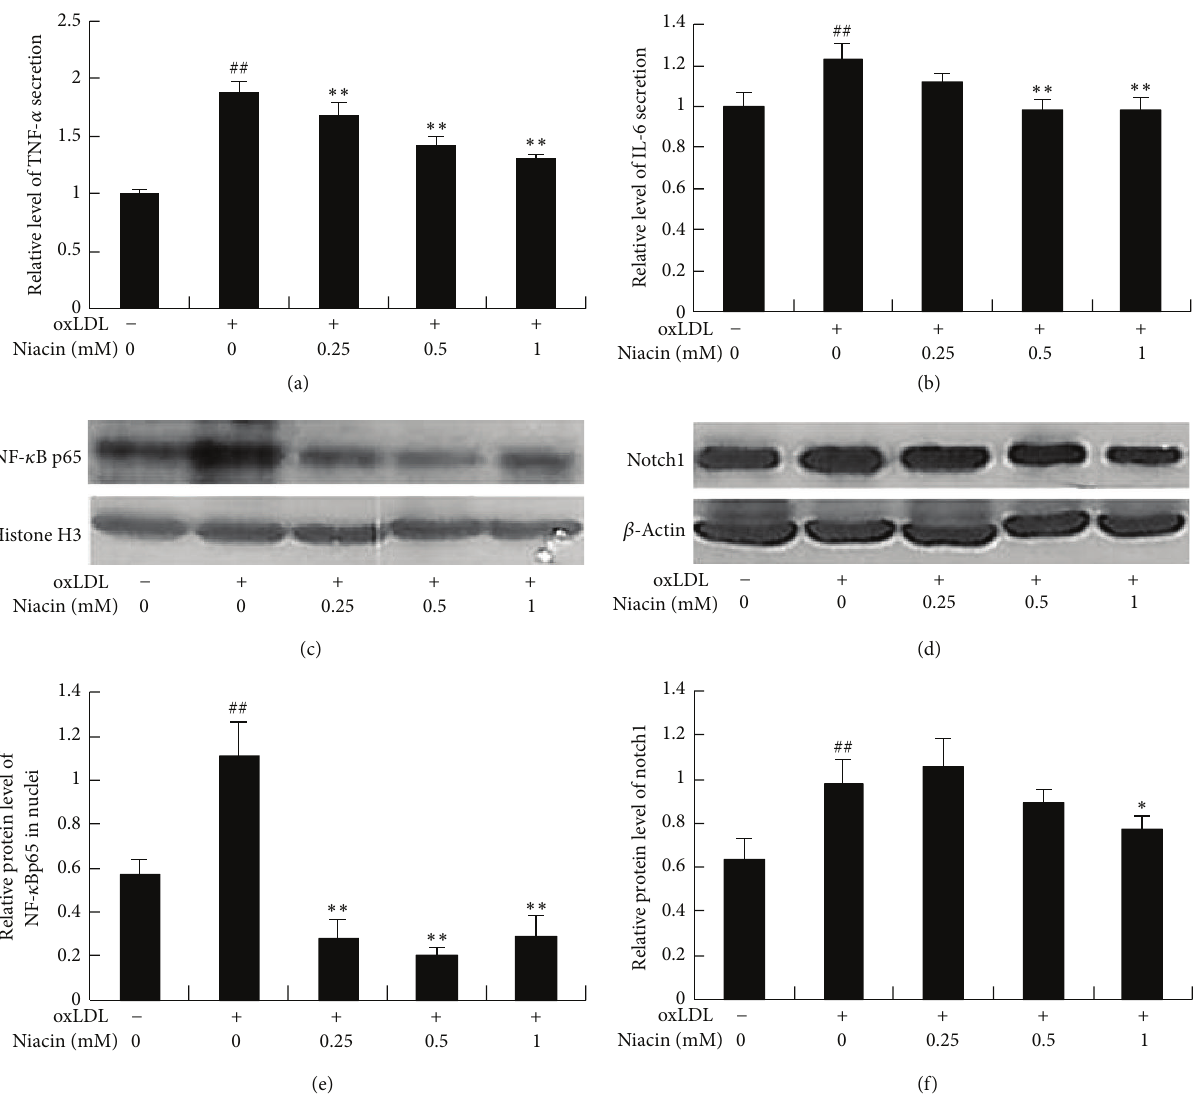
Figure 5: Niacin decreased the secretion of TNF- 𝛼 and IL-6 and inhibited NF- 𝜅 B and notch1 expression in oxLDL-stimulated THP-1 macrophages. (a) and (b) show the relative levels of TNF- 𝛼 and IL-6 secretion in the medium of THP-1 macrophages. The concentrations of IL-6 and TNF- 𝛼 were determined by ELISA kit. (c) and (d) show the representative images of NF- 𝜅 B p65 and notch1 protein expression in THP-1 macrophages by western blot. (e) and (f) show the IOD ratios of NF- 𝜅 B p65 and notch1 expression, respectively. Data are presented as mean ± SD. ## 𝑃 < 0.01 versus blank group; ∗ 𝑃 < 0.05 ; ∗∗ 𝑃 < 0.01 versus oxLDL-treated group without